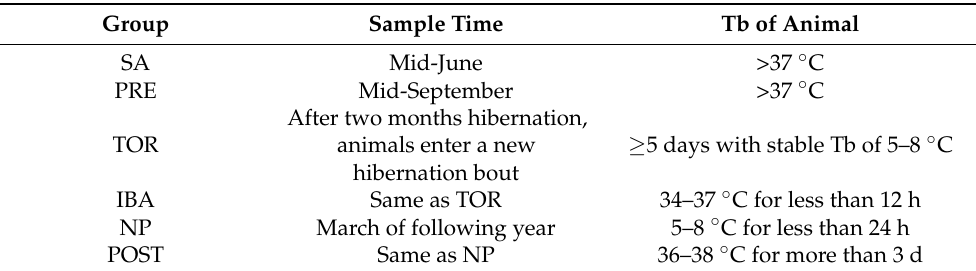
Table 1. Animal groups and sample times. Animals were divided into six groups and sampled between June of that year and March of the following year. Group Sample Time Tb of Animal SA Mid-June >37 ◦ C PRE Mid-September >37 ◦ C After two months hibernation, TOR animals enter a new hibernation bout Same as